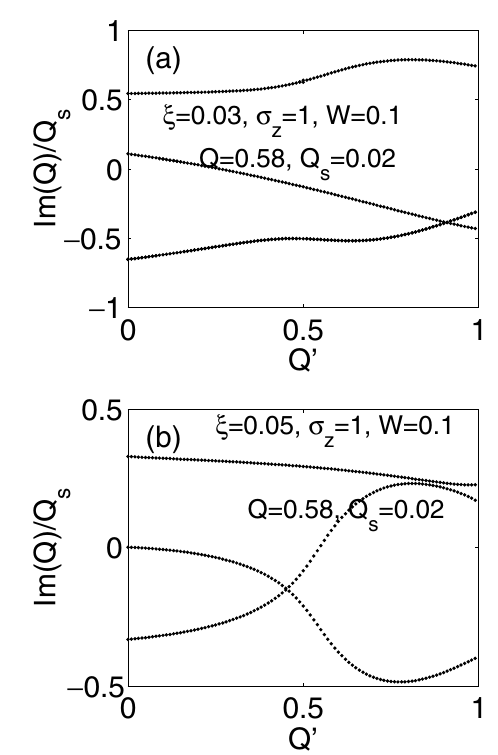
FIG. 3. Chromaticity dependence. (a) (cid:23) (cid:4) 0 : 03 ; (b) (cid:23) (cid:4) 0 : 05 .